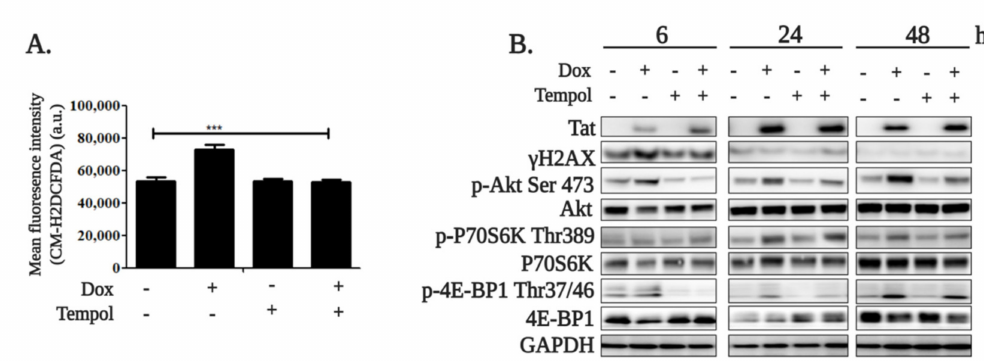
Figure 3. Activation of the Akt/mTORC1 axis is dependent on the DNA damage induced by reactive oxygen species (ROS) production. ( A ) Tat expression was induced in the RPMI-8866 cells by treating with 1 µ g/mL doxycycline for 6 h (Dox) in the presence or absence of 80 µ M Tempol. ROS production was measured by flow cytometry after CM-H2DCFDA staining as described in the Materials and Methods. Staining intensity is represented as the mean fluorescence in arbitrary units. ( B ) Tat and phosphorylated and non-phosphorylated forms of Akt, P70S6K and 4E-BP1 were analyzed in Tat-expressing cells, in cells treated with Tempol at a final concentration. The results of three independent experiments are expressed as the mean ± SEM. The statistical significance was calculated vs. untreated controls; *** p < 0.001